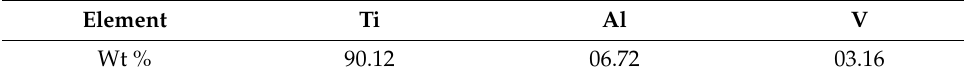
Figure 9. General view of the broken femoral nail’s shaft; its proximal (1) and distal (2) parts ( a ) with a set of assembling parts: proximal part of the broken nail’s shaft (1); blocking bolt (3); nail’s screw (4); two self-tapping locking screws (5 and 6); telescopic lag screw (7); end cap (8); anti-rotation pin (9); cap (10) ( b ). Table 4. Chemical composition of the titanium alloy femoral/pelvic implant.